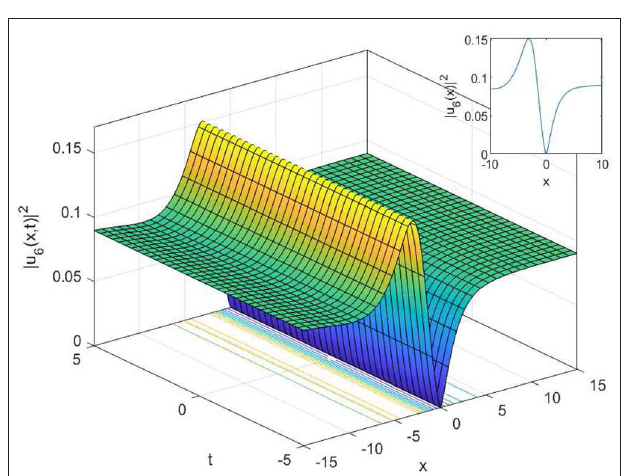
FIGURE 3 | 3D, 2D, and contour surfaces of Equation (30) where γ 0.5, c 1 0.7, α 0.9. = = =